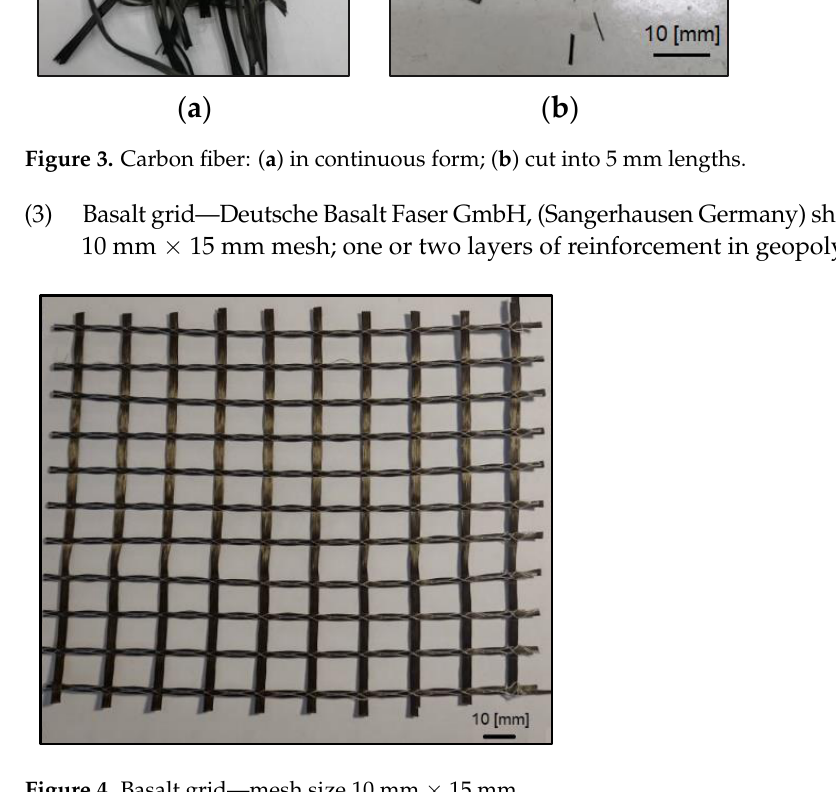
Figure 4. Basalt grid — mesh size 10 mm × 15 mm.